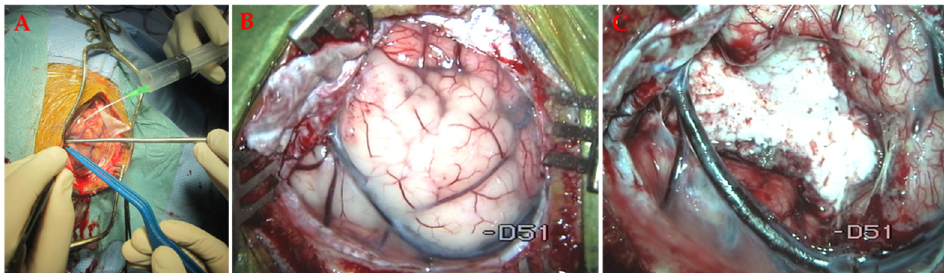
Figure 5. ( A ) Brain exposure in open glioma surgery. ( B ) The primary brain tumour is clearly visible on the surface. The tumour tissue is more swollen and tan white. ( C ) The resection cavity after tumour removal. The drainage vein below the tumour was left in place because it is essential to maintain normal brain drainage. All images were taken during routine neurosurgical procedures at our medical centre with patient and ethical committee approval.